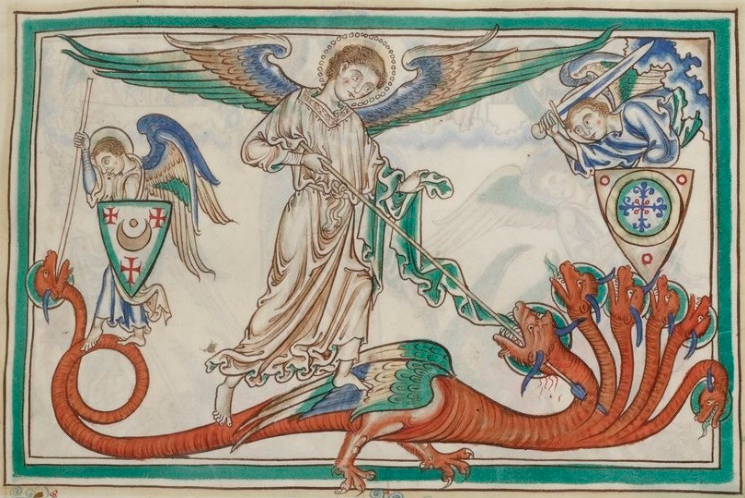
Figure 1. Paris Apocalypse (Paris, Biblioth è que Nationale de France MS fr.403). Fol. 20r, c. 1250–55, © Biblioth è que Nationale de